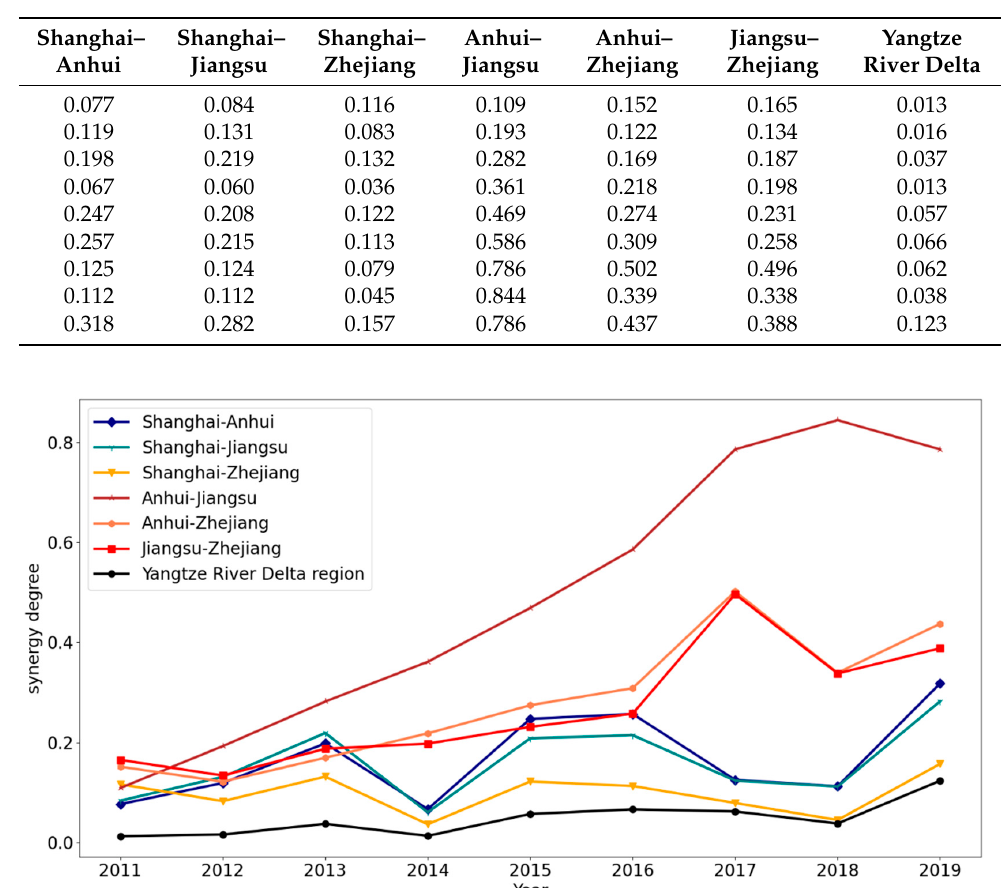
Figure 7. Synergetic degree of carbon emission subsystems in the Yangtze River Delta region from 2010 to 2019.